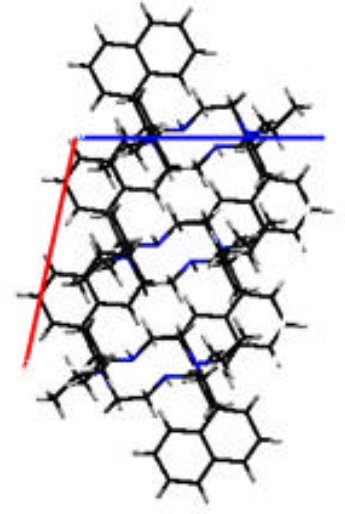
Figure 3. Packing diagram, viewing along the b axis of the unit